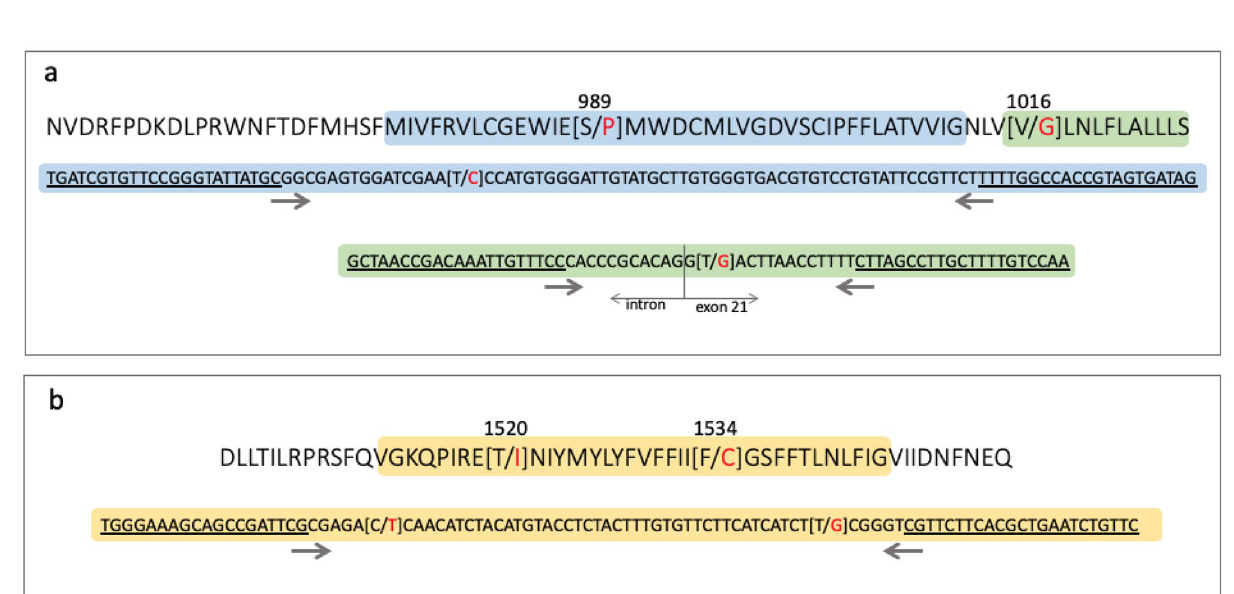
Figure 6. Representation of the IIS6 ( a ) and IIIS6 ( b ) Na V segments with their respective amino acid (above) and nucleotide (bellow) sequences. The SNPs at 989, 1016, 1520, and 1534 sites are indicated inside brackets with the mutant alternative in red. The shaded colors indicate the amplified sequences in the HRM reactions, with their respective primer sequences underlined and orientation following the